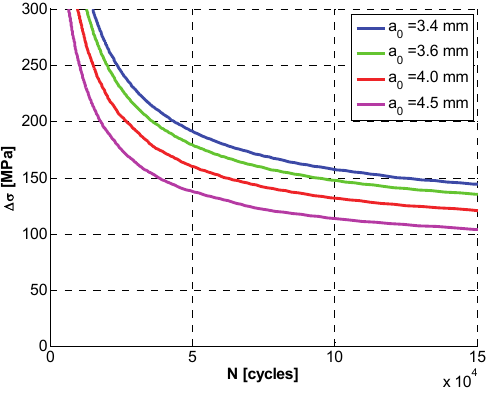
Figure 10: S-N field in propagation as derived from the crack growth